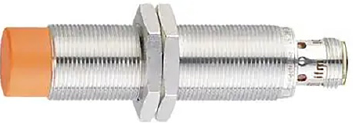
Figure 4. Physical drawing of inductive proximity switch.